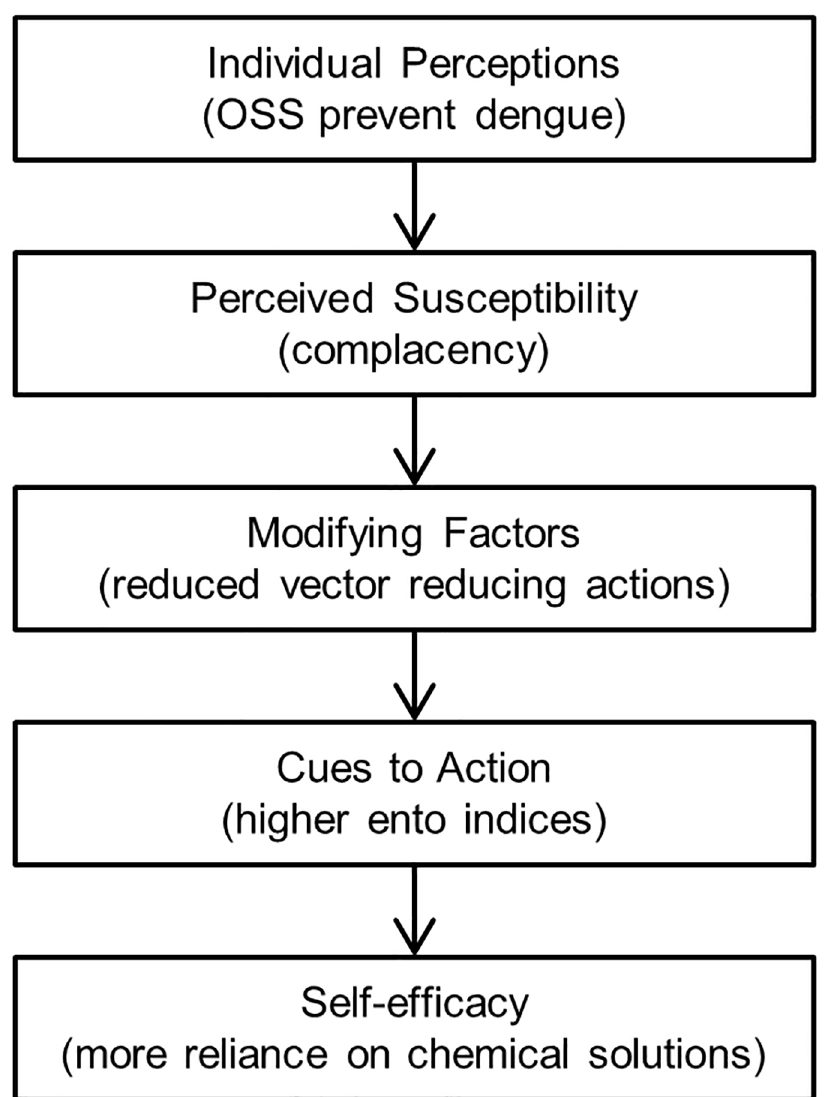
Fig 3. Pathway of associations between OSS perception, residents’ prevention practices and entomological